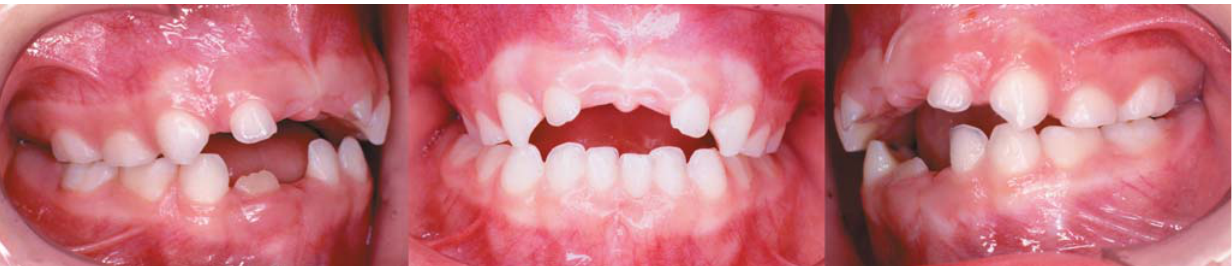
FIGURE 2- Lateral and frontal views at the beginning of treatment